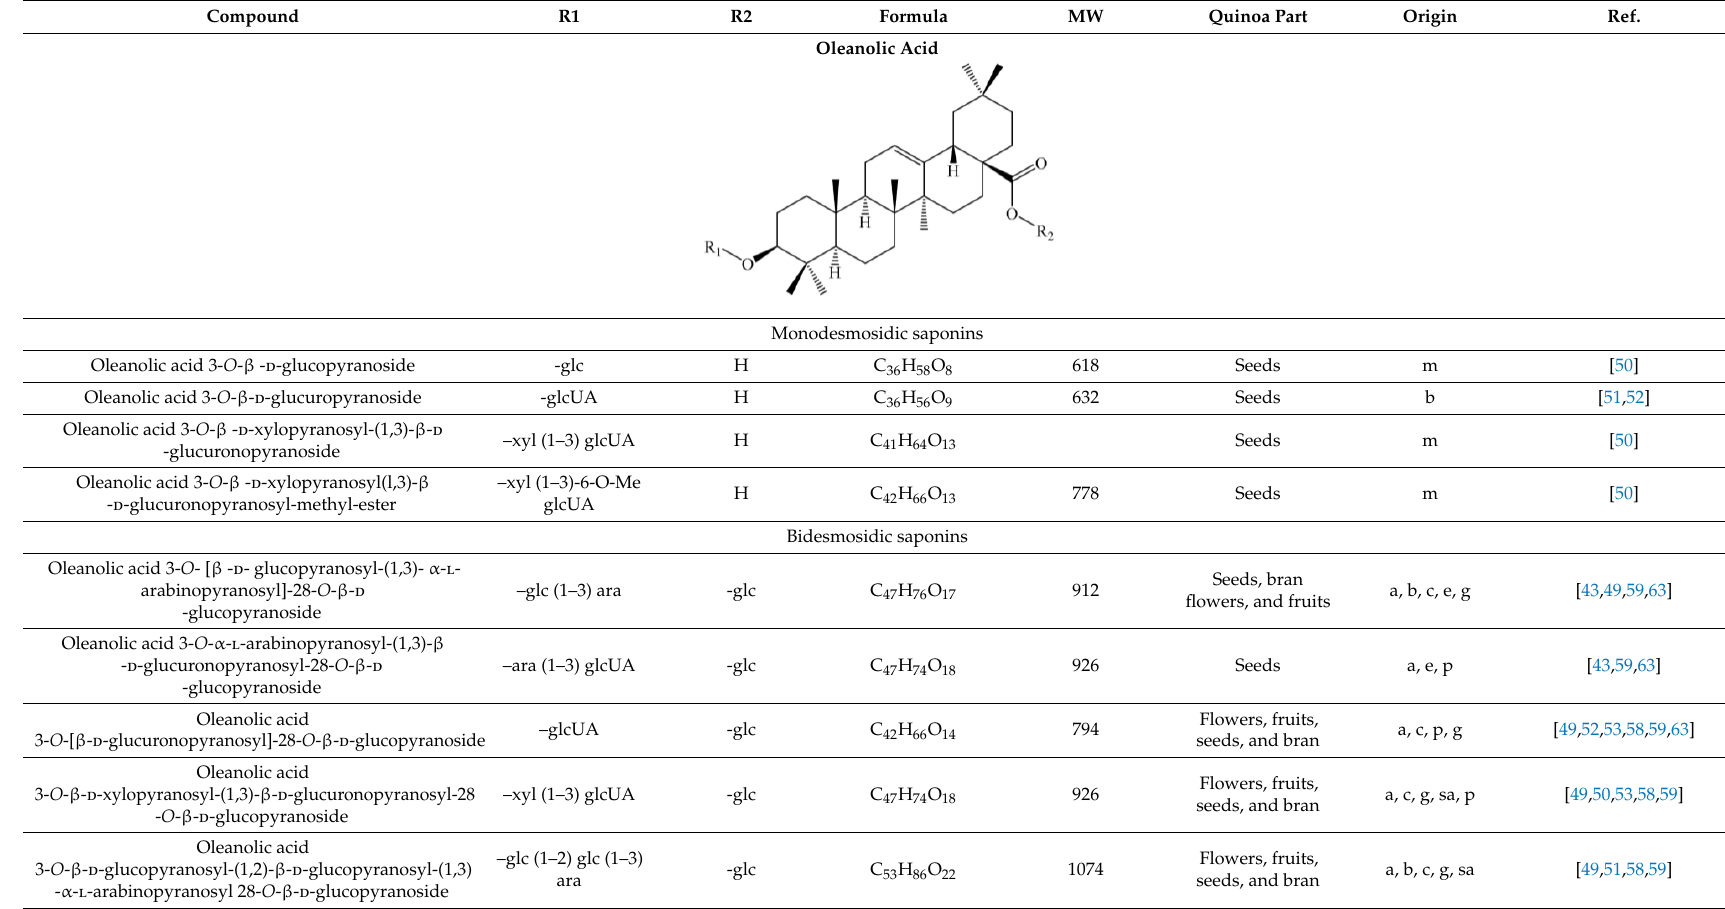
Table 3. Triterpene saponins isolated from C. quinoa Willd.